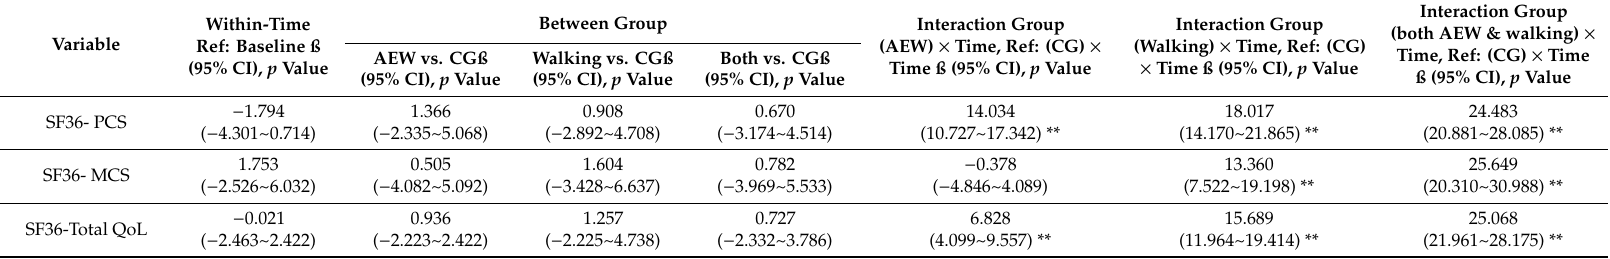
Table 6. Evaluation of the intervention on the quality of life in participants with T2DM based on general estimating equation analysis ( n = 81).